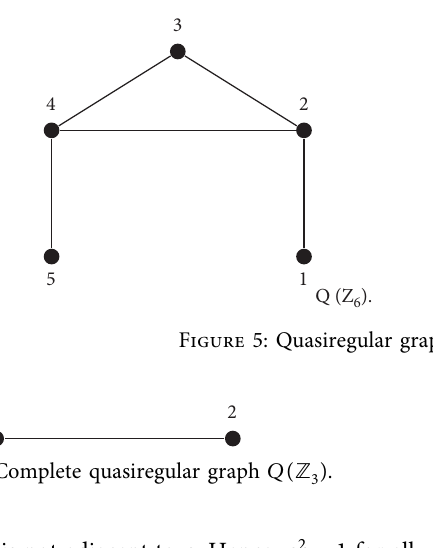
Figure 6: Complete quasiregular graph Q ( Z